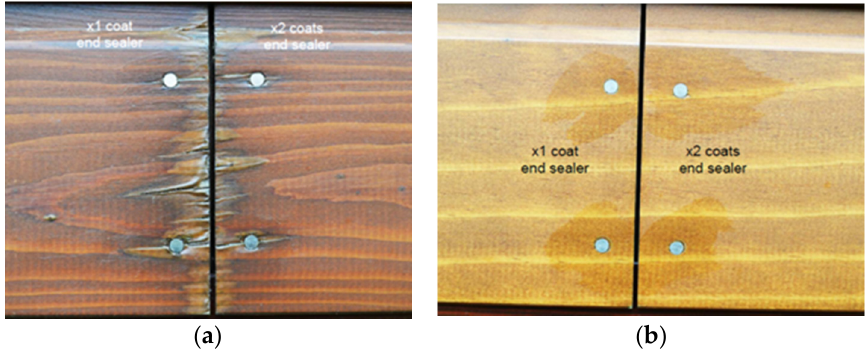
Figure 11. Control (larch, ( a )) and acetylated (pine, ( b )) samples after 7 years.